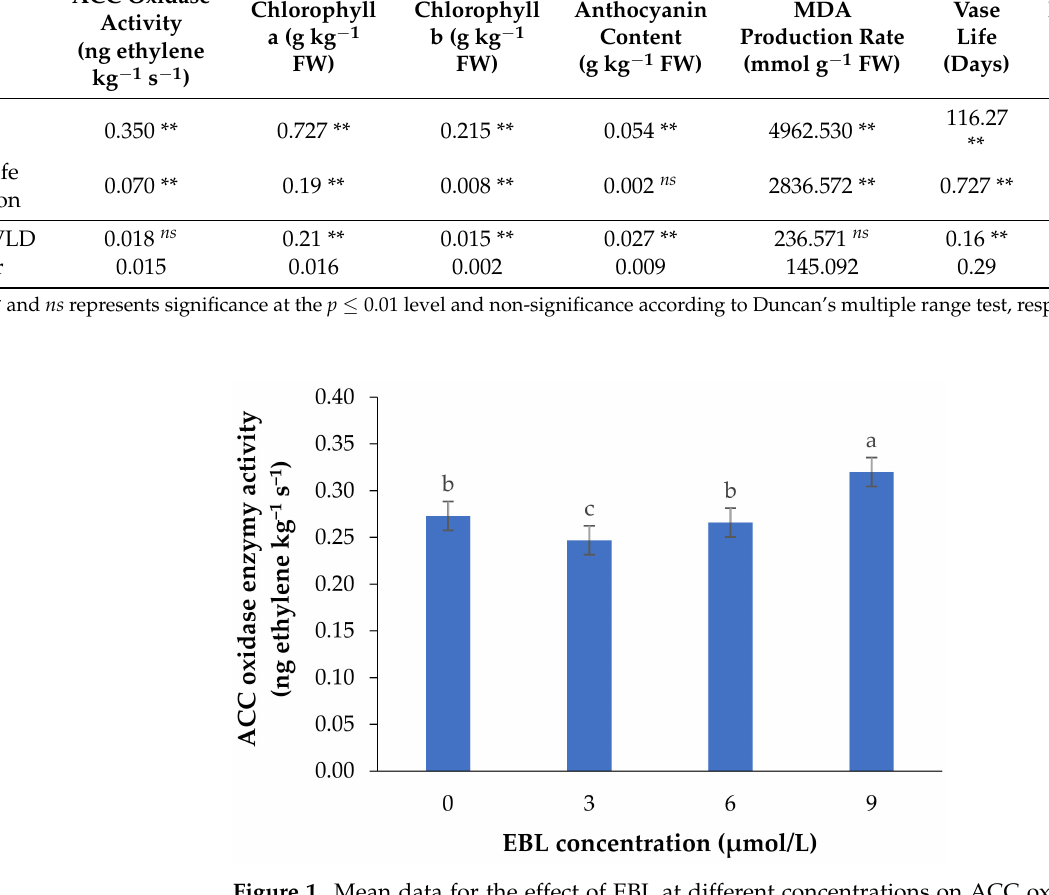
Figure 1. Mean data for the effect of EBL at different concentrations on ACC oxidase activity in lisianthus cut flowers during 14 days of storage at room temperature. Error bars represent the standard error of means of four replicates. Columns indicated by different letters are significantly different according to Duncan’s multiple range test ( p ≤